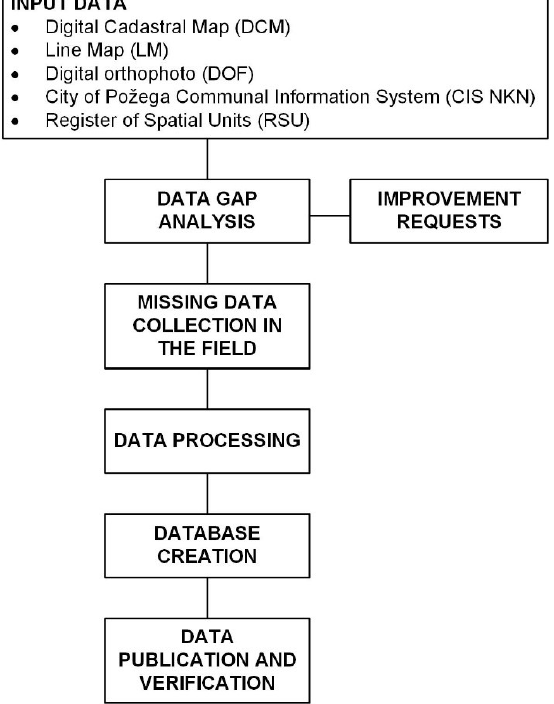
Figure 1. Schematic workflow diagram representing research